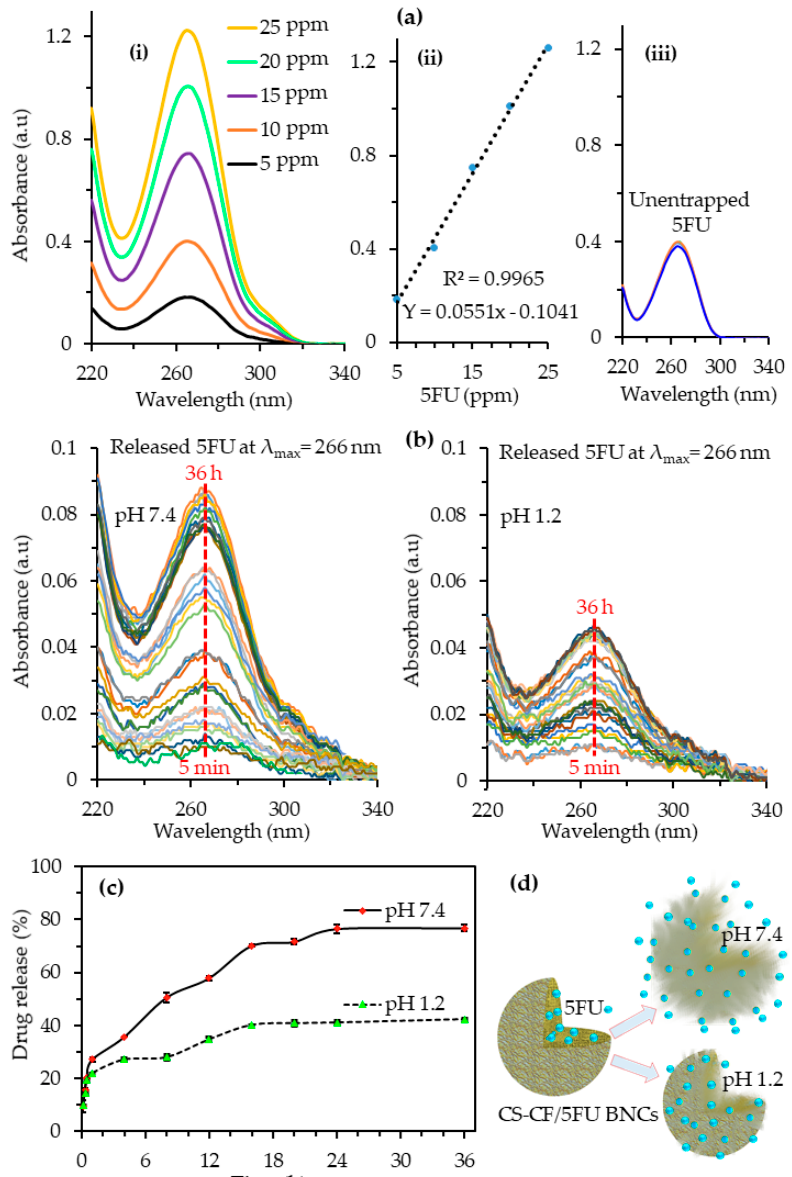
Figure 7. ( a ) ( i ) The 5FU absorbance and ( ii ) calibration curve at λ max = 266 nm from known concentrations of 5FU (5–25 ppm); ( iii ) UV-vis spectra of the unentrapped 5FU; ( b ) UV-vis spectra and ( c ) the release kinetics of 5FU from CS-CF/5FU BNCs; ( d ) a schematic of possible drug release. Data is expressed as the mean ± standard deviation for triplicates within an individual experiment.